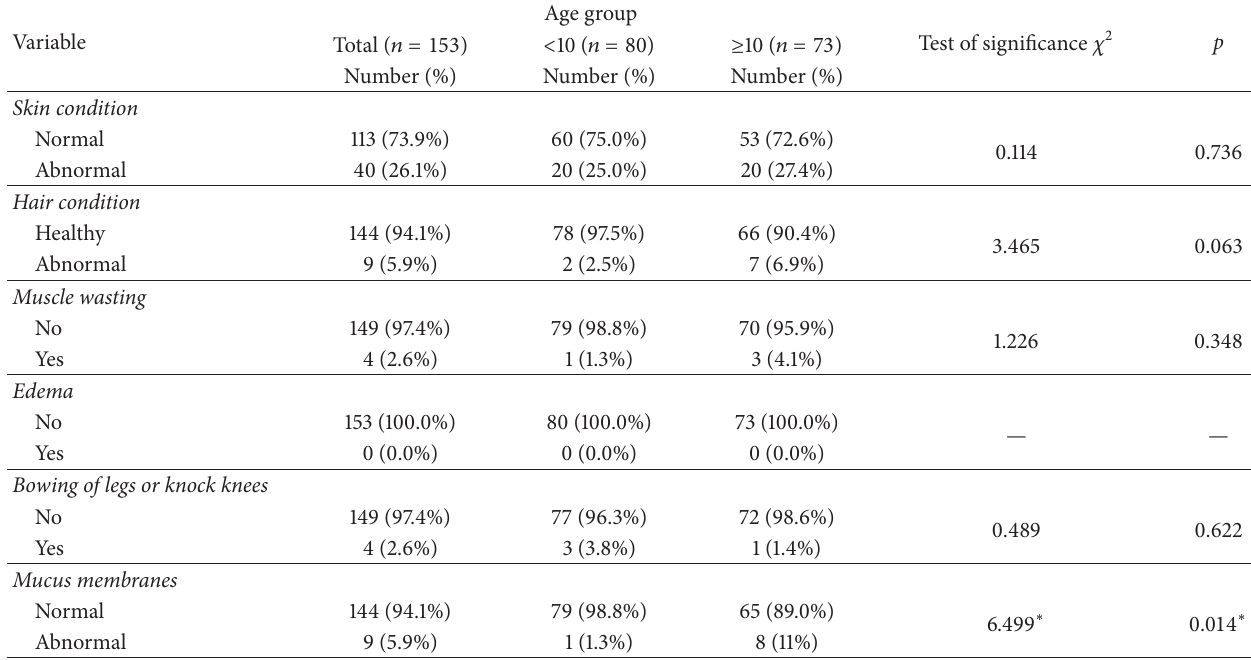
Table 1: Clinical